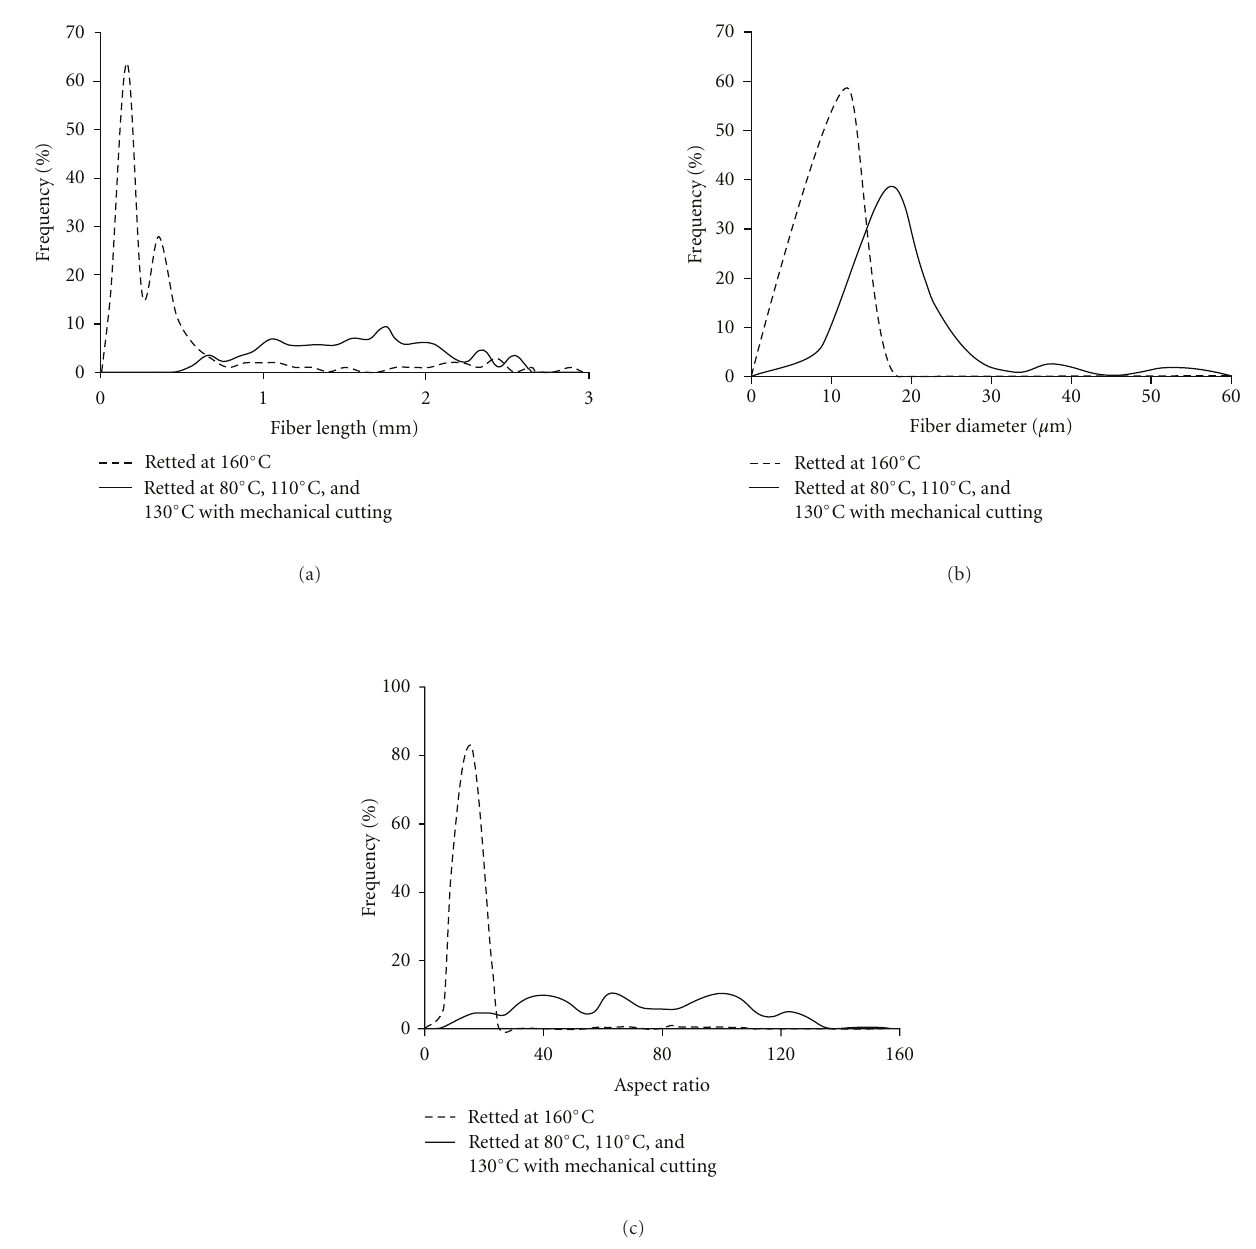
Figure 2: Dimensional distribution of the digested fibers. (a) length distribution, (b) diameter distribution, (c) aspect ratio distribution.